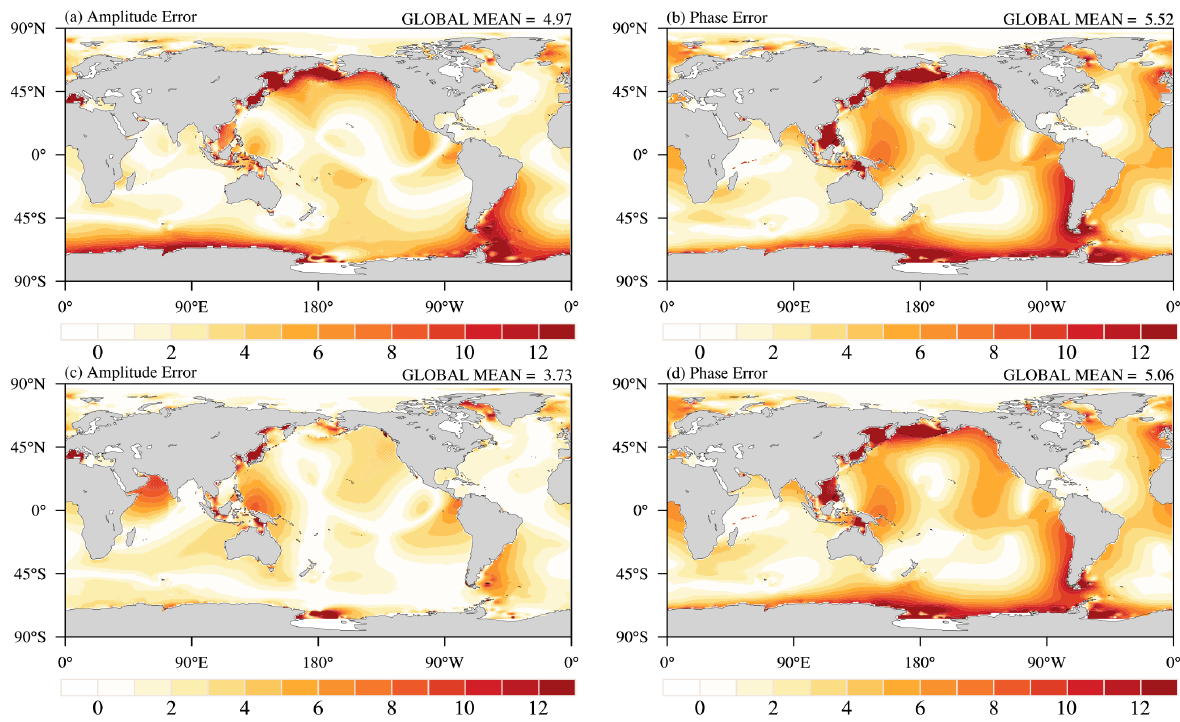
Figure 5. The contributions to the total error of K1 resulting from errors in (a) tidal amplitude and (b) phase for Exp1; (c) and (d) are the same, but for Exp2. The units are